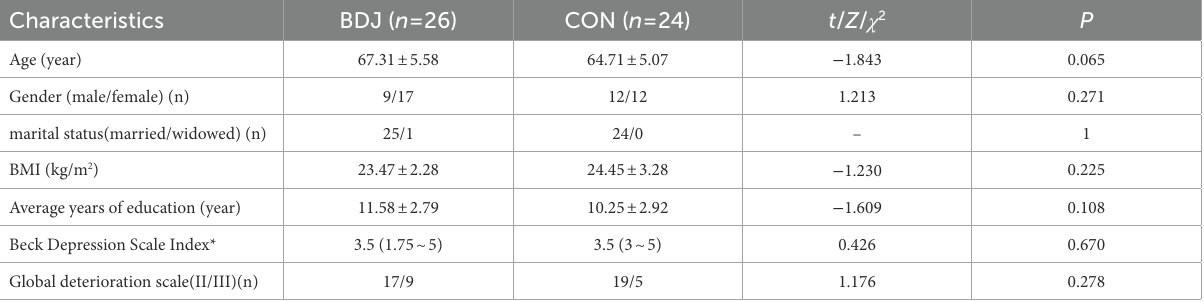
TABLE 1 Comparison of baseline characteristics between two groups [ratio/ / X S M